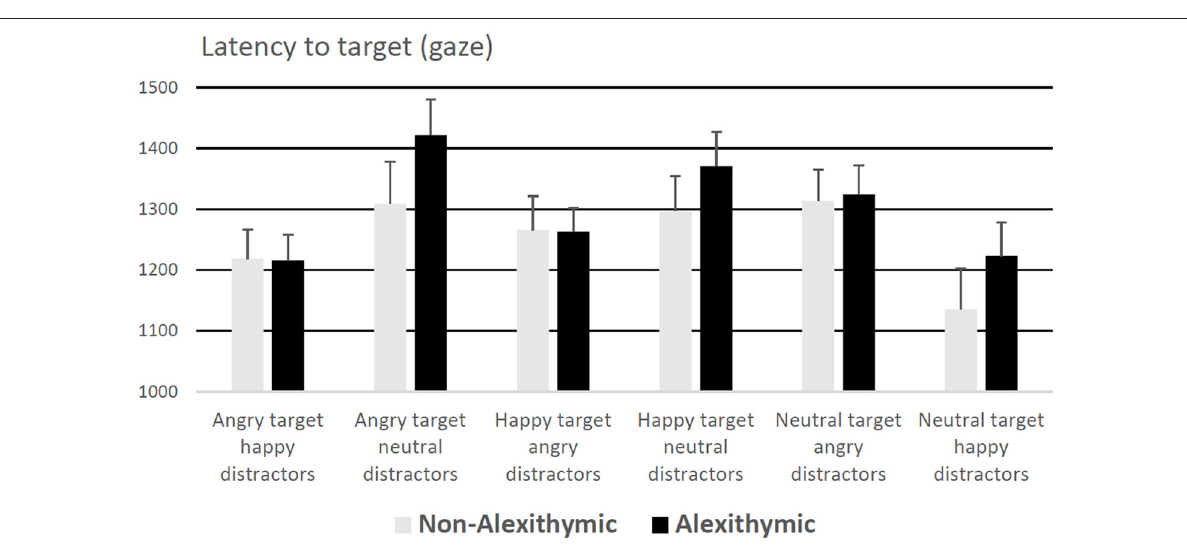
Independent of group, participants fixated more distractor faces after fixating the target in the conditions “angry target neutral distractors” and “neutral target angry distractors” than in the other experimental